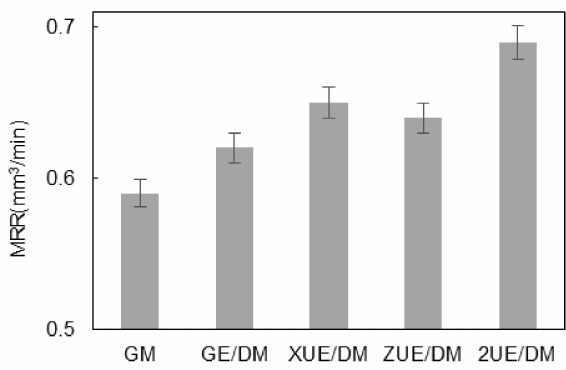
Figure 6. Comparison of machining